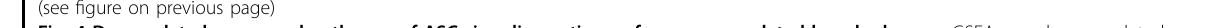
Fig. 4 Dysregulated genes and pathways of ASCs in adipose tissues from cancer-related lymphedema. a GSEA reveals upregulated or downregulated pathways of ASCs in CASE versus CTRL. An FDR q value < 0.05 was considered to be statistically signi fi cant. b Comparative analysis of the gene regulatory networks of ASCs between the CASE (lower panel) and CTRL (upper panel) groups reveals dysregulated genes in ASCs. The node size re fl ects the degree centrality. The representative genes dysregulated in CASE ranked by delta degree are labeled in red. c Network view of the functional enrichment for the dysregulated genes shown in b . The small dots denote genes and large nodes represent Gene Ontology terms. The node size represents the number of genes associated with the Gene Ontology term. Adjusted P value < 0.05. d Delta degree centrality (upper panel) and average expression across cells in CASE and CTRL (lower panel). CASE, cancer-associated lymphedema; CTRL, healthy